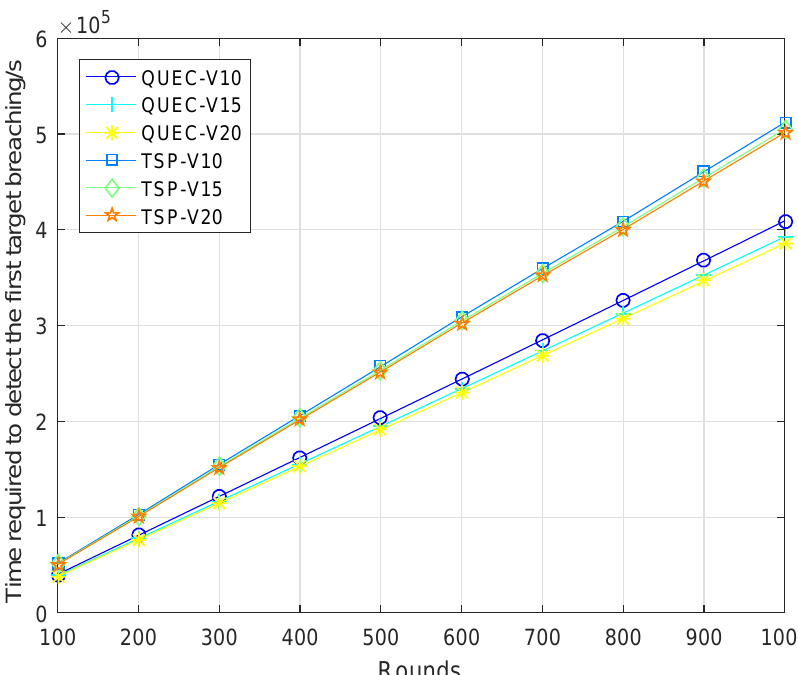
Figure 6. Time required to detect the first target breaching.